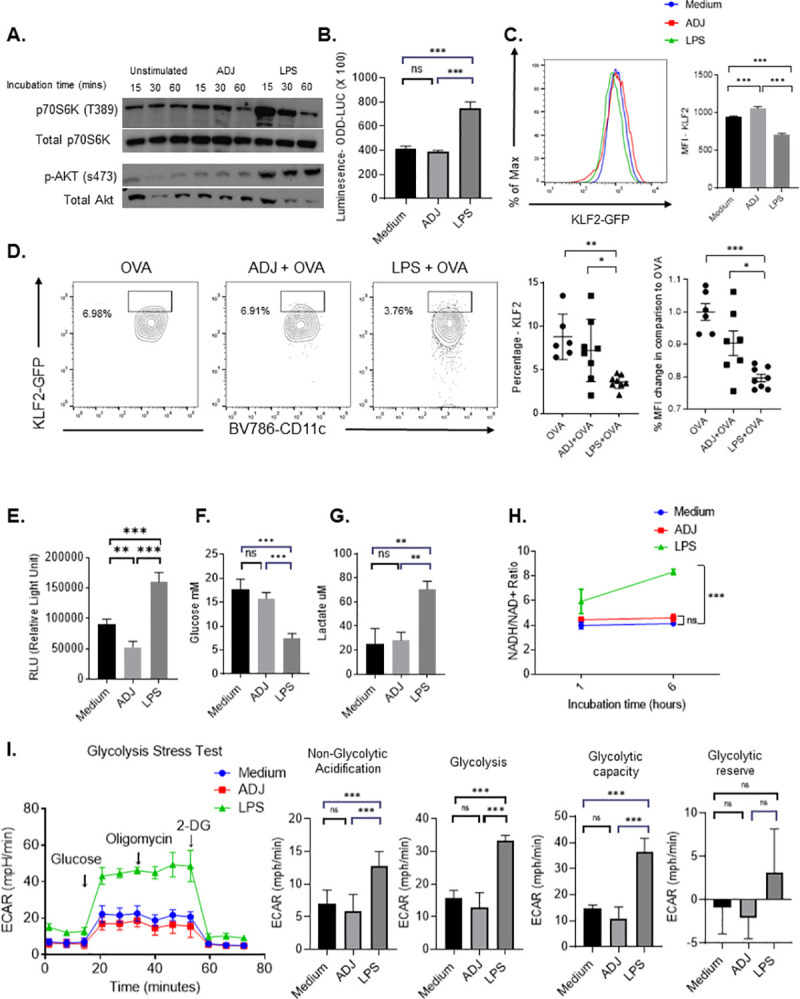
Carbomer-based adjuvant rewires DC metabolism without engaging aerobic glycolysis driven by the Akt-mTORC1-KLF2-HIF1α signaling axis.(A) Immunoblot for total AKT and AKT phosphorylated at Ser473 or total p-S6K and p-S6K phosphorylated at Thr389 in BMDCs following 15, 30, 60 mins of culture with and without ADJ (1%) or LPS (100ng/ml). (B) HIF-1α induction was measured by quantifying luciferase activity in DCs derived from ODD-Luc mice; DCs were stimulated with ADJ (1%) or LPS (100ng/ml) for 24 h. (C) In vitro KLF2 expression in DCs; DCs derived from KLF2-GFP mice were treated with or without ADJ (1%) or LPS (100ng/ml) for 24 hours, and KLF2-GFP expression was assessed by flow cytometry (D) KLF2-GFP reporter expression (gated on CD11cHI/MHC-IIHI cDC population) was measured in DCs from inguinal lymph nodes after 24 h of intradermal footpad vaccination. (E) Intracellular ATP was quantified in unstimulated, ADJ- or LPS-stimulated DCs at 24 h. (F-G) Extracellular glucose levels and secreted lactate in cell culture supernatant were measured in cultures of unstimulated, ADJ-, and LPS-stimulated DCs at 24 h. (H) NADH/NAD+ ratio in resting, ADJ- or LPS-stimulated DCs at the indicated time-points (1 and 6 hours). (I) BMDCs were treated with ADJ (1%) or LPS (100ng/ml) for 24 h; real-time ECAR was determined during sequential treatments with glucose, oligomycin, and 2-DG. Quantification of basal glycolysis (ECAR), glycolytic capacity and glycolytic reserve. The glycolytic reserve capacity of cells was measured as the difference between ECAR before and after addition of oligomycin. Data are representative of 2–3 independent experiments (A, B, C, E-I). Data in D are pooled from two independent in vivo experiments and each symbol represents an individual mouse. Error bars show SEM; *P<0.01; **P<0.001; ***P<0.0001 (B-I; one-way ANOVA).